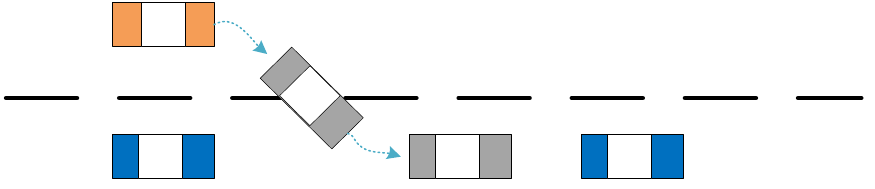
Figure 1. Schematic diagram of lane change behavior in adjacent lanes.